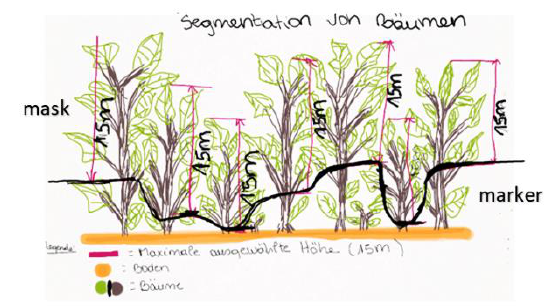
Figure 5 . Delimitation of the mask and